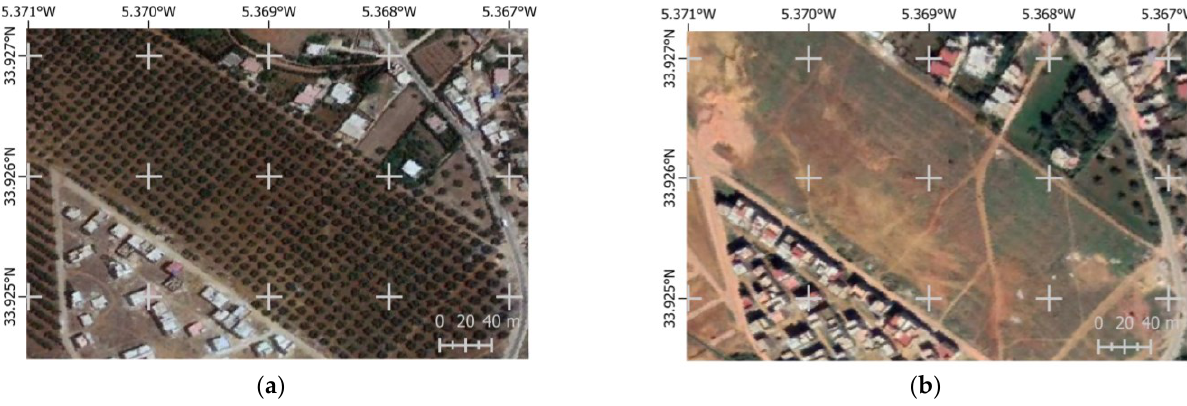
Figure 14. Agricultural land use changes from intensive olive plantations to land preparation for urbanization purposes: ( a ) 2010, ( b ) 2020. Source: Google Earth Images 2020.